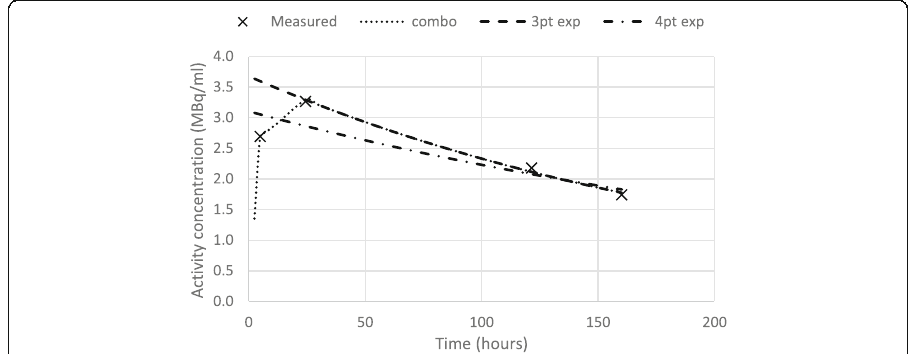
Fig. 1 Example illustrating the different extrapolations of the TACC used for calculation of absorbed dose and effective half-life. The trapezoidal rule from injection to 24 h is used in the “ original ” combined method, and curve fits to a 3- or 4-point mono-exponentials are